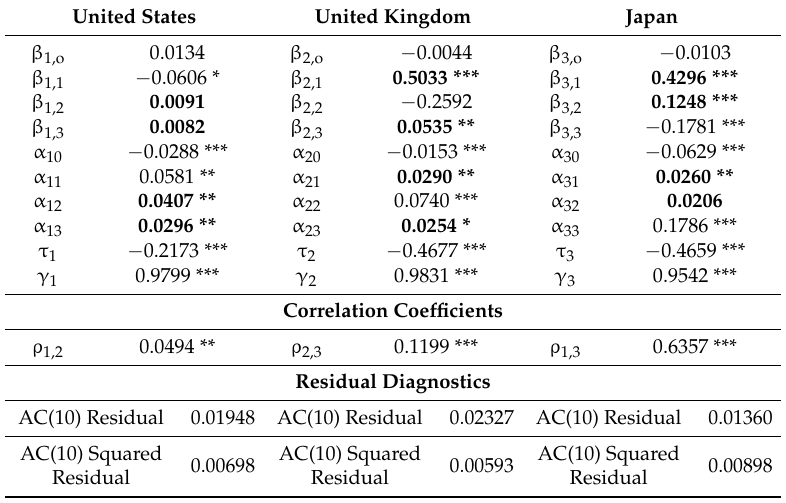
Table A6. Estimation from the multivariate MVR-EGARCH model (Islamic equities—crisis). United States